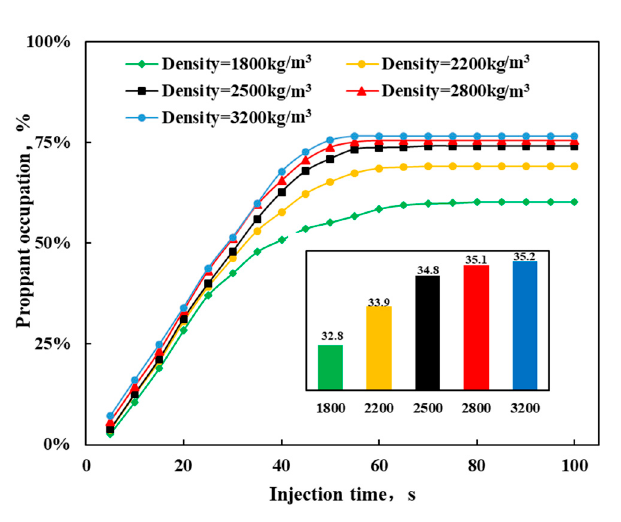
Figure 14. The curve for proppant occupation percentage in fracture change with time and CEH for different inlet particle density.